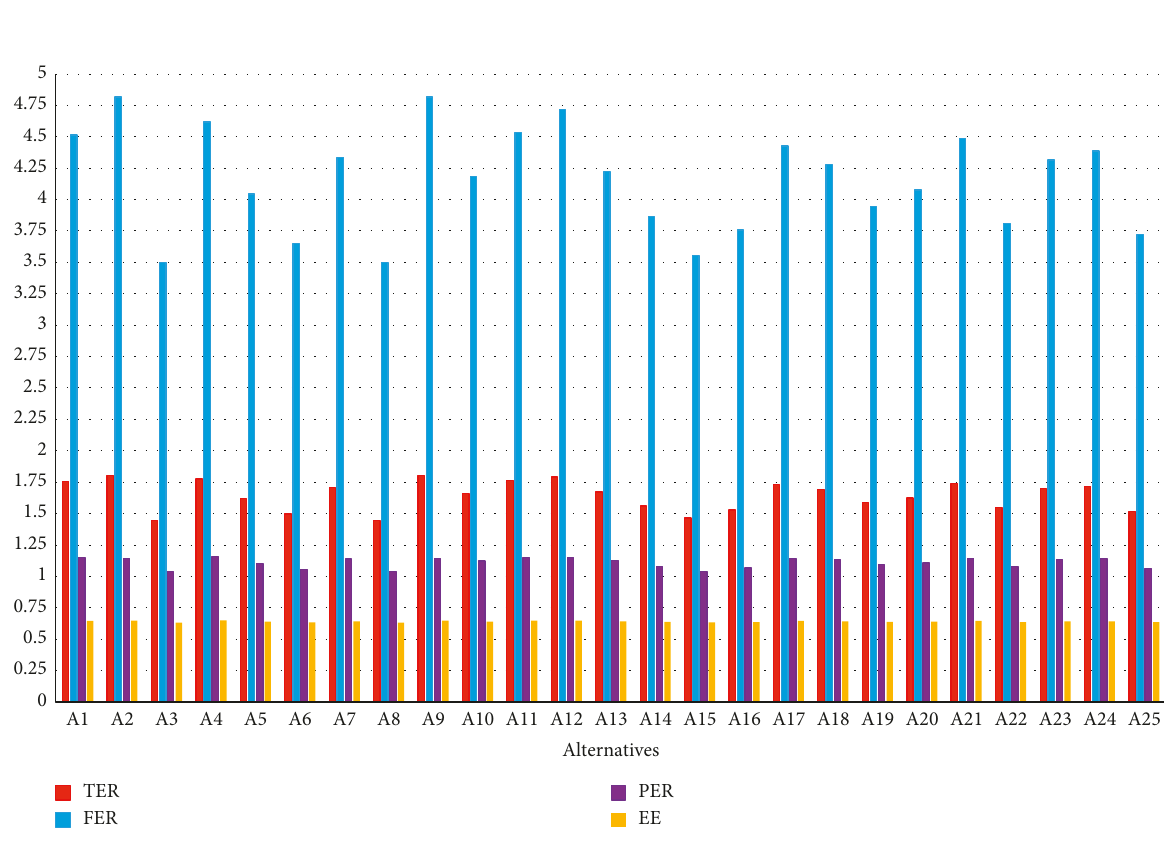
Figure 16: Inconsistency of criteria values with